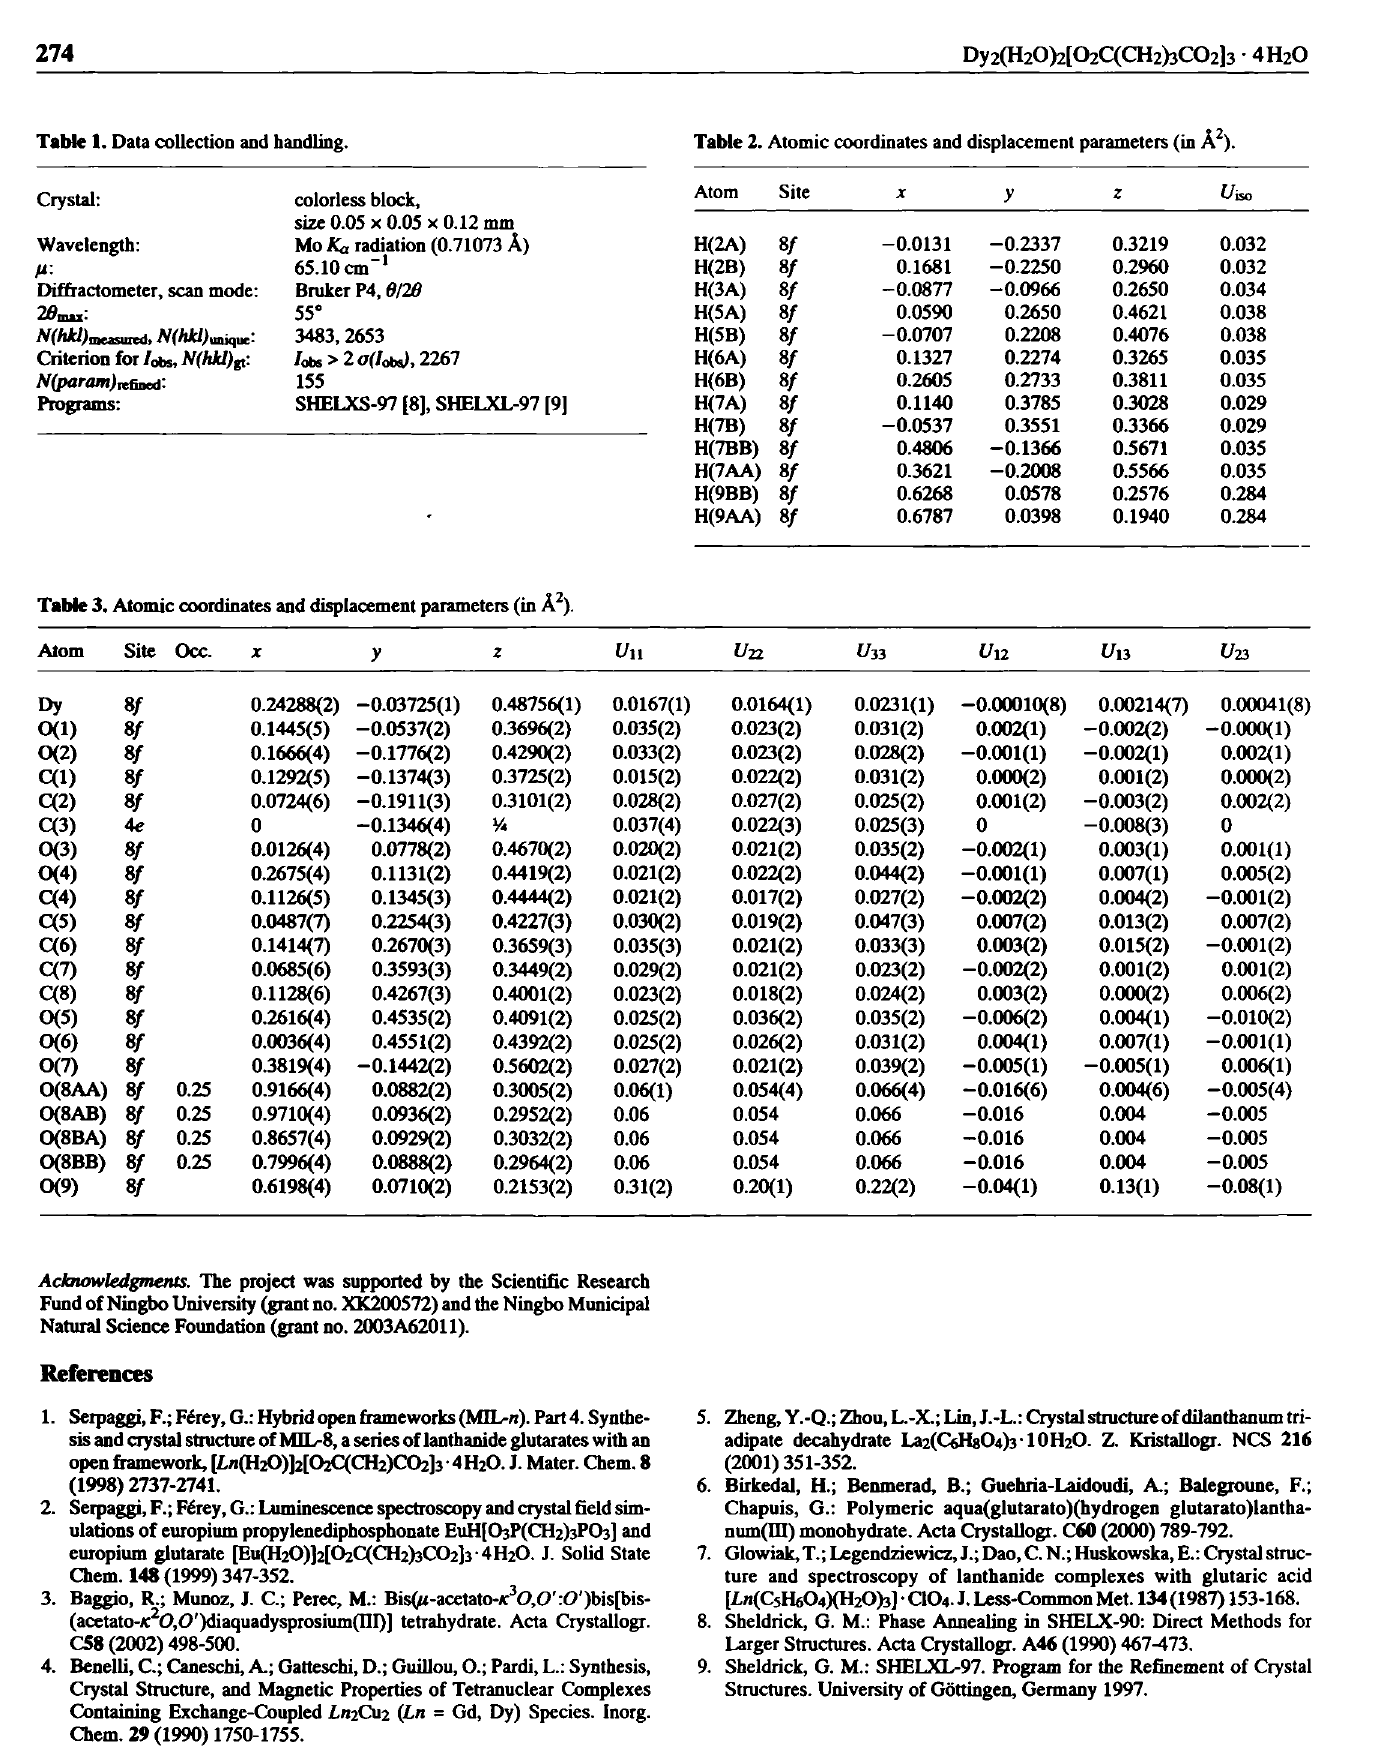
Table 1. Data collection and handling. Table 2. Atomic coordinates and displacement parameters (in A 2 ).